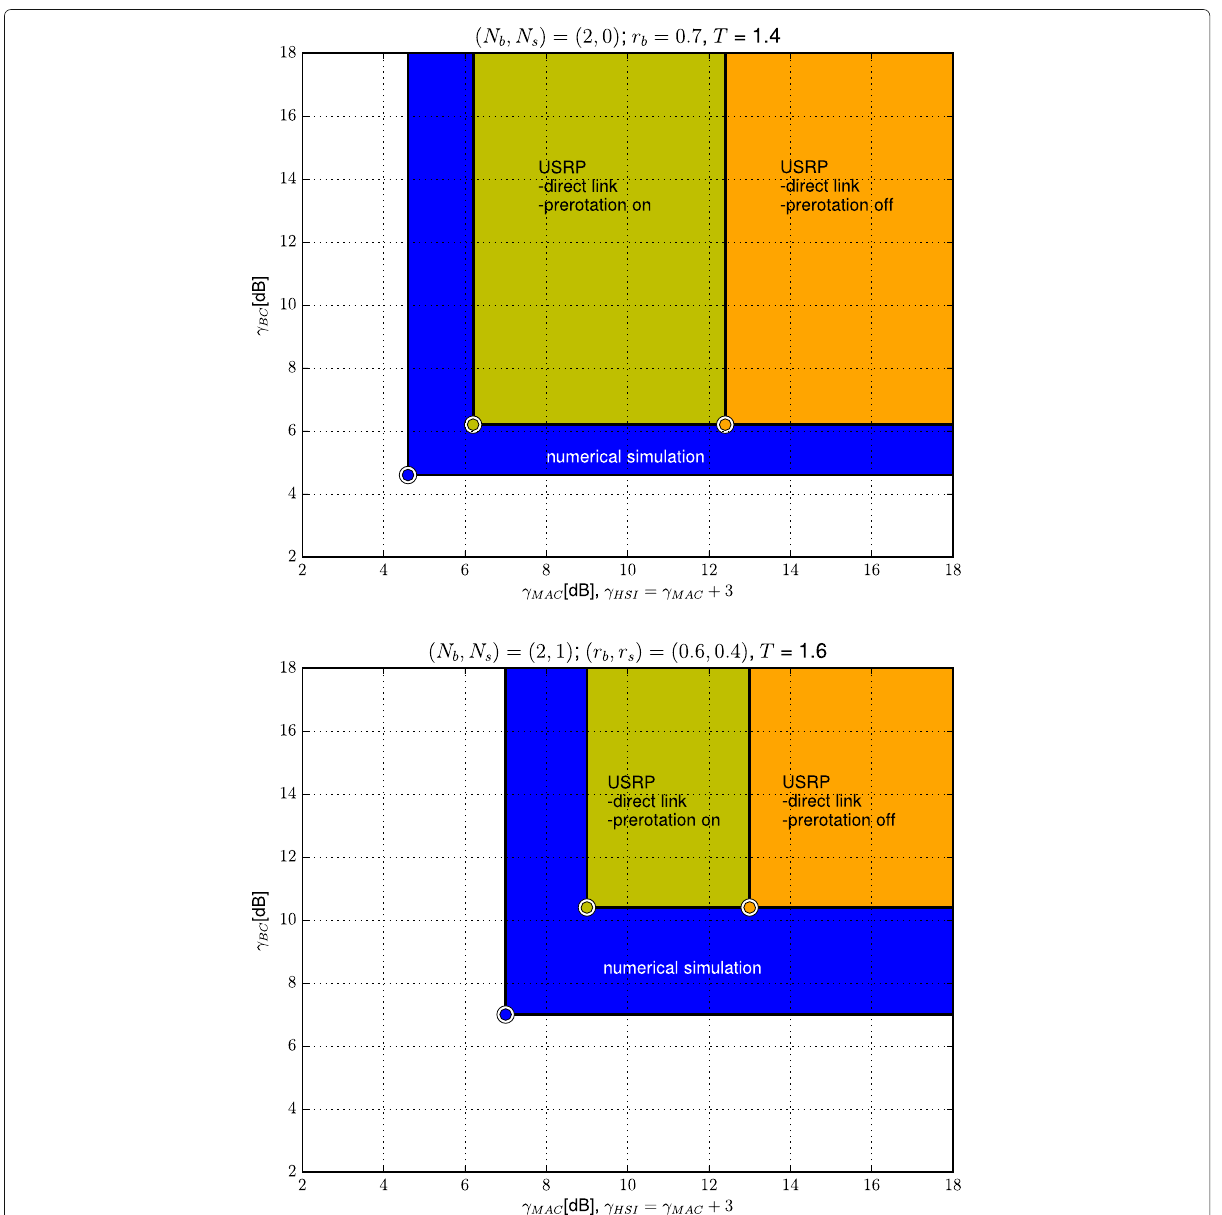
Fig. 17 Robustness analysis for two fixed ( N b , N s , r b , r s )